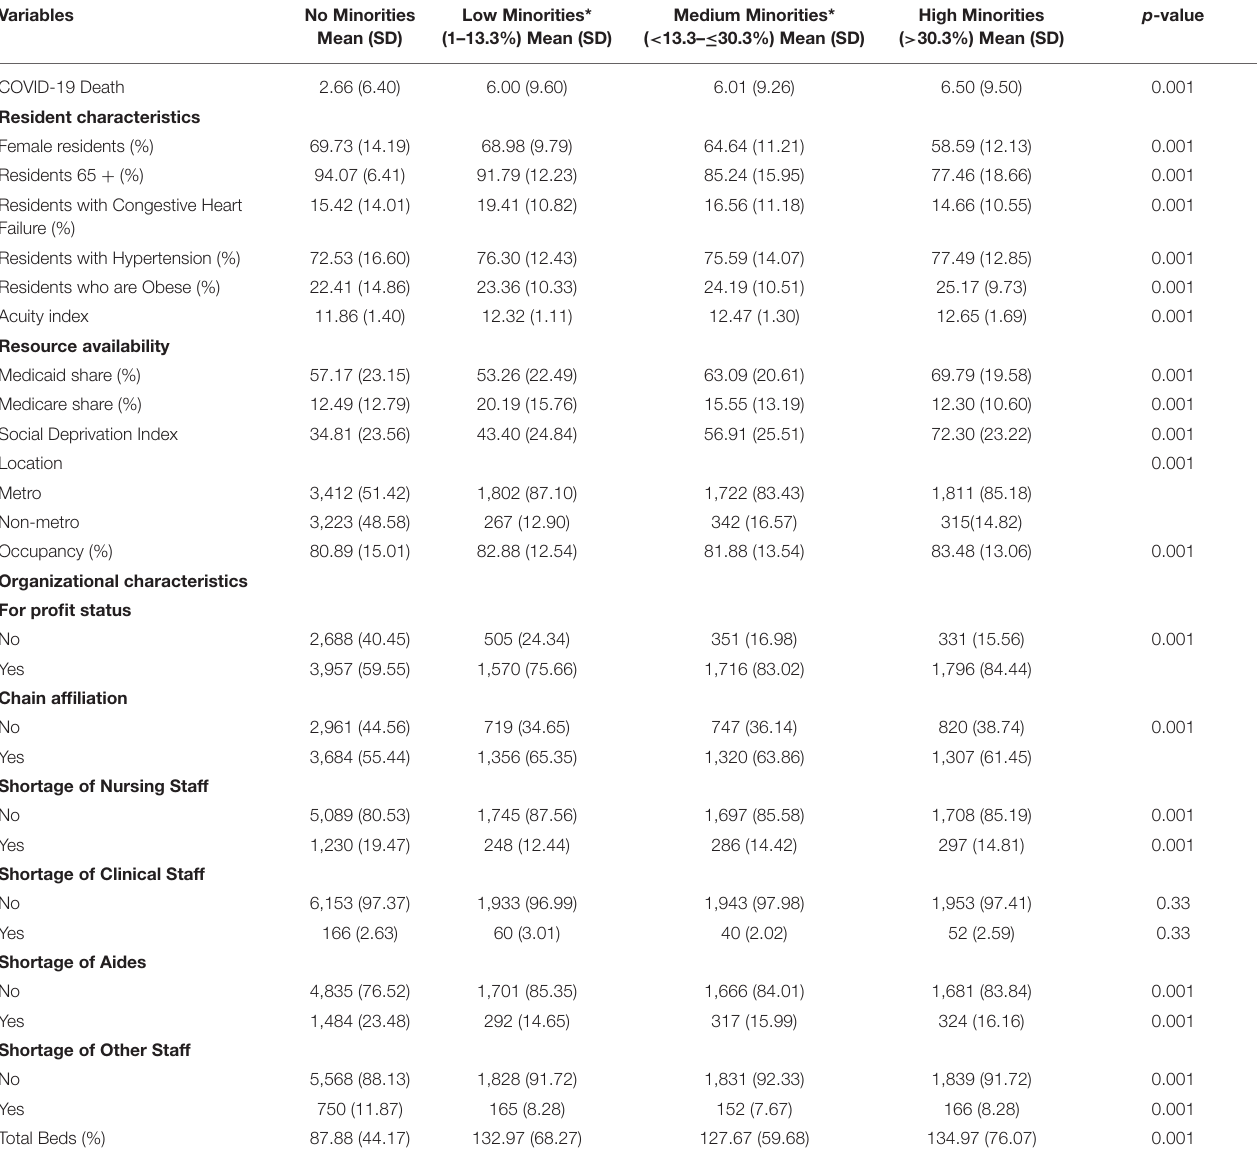
TABLE 1 | Bivariate statistics of the relationship between study variables and nursing home racial/ethnic mix ( N = 12,914).